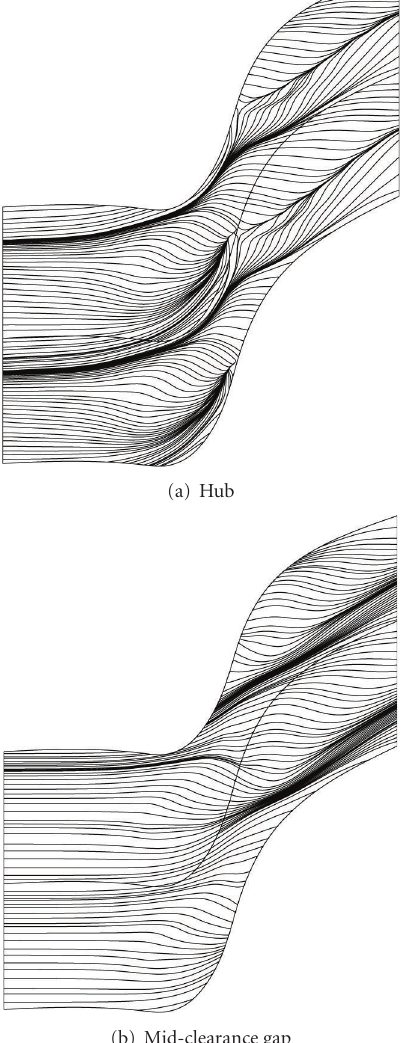
Figure 13: Stream lines.